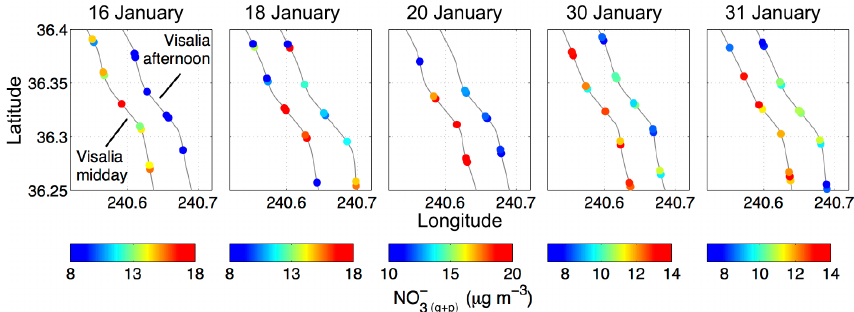
Figure C1. NO − (µgm − 3 ) in PM 2 . 5 measured during 10 missed approaches on 5 days over Visalia. The left-hand flight track is 3 ( g + p ) the midday (12:00–13:00LT) missed approach and the right-hand track, shifted east by 0.02 ◦ , is the afternoon (15:00–16:00LT) missed